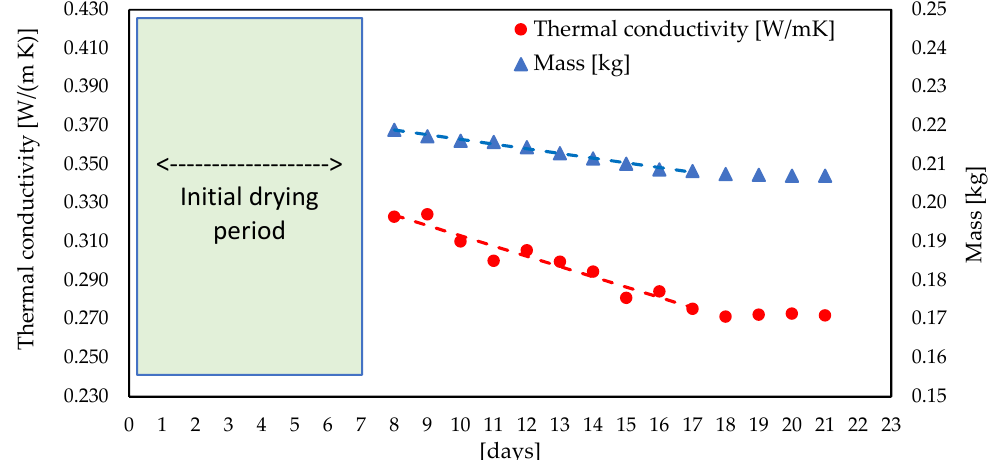
Figure 6. Effect of water content on thermal conductivity.